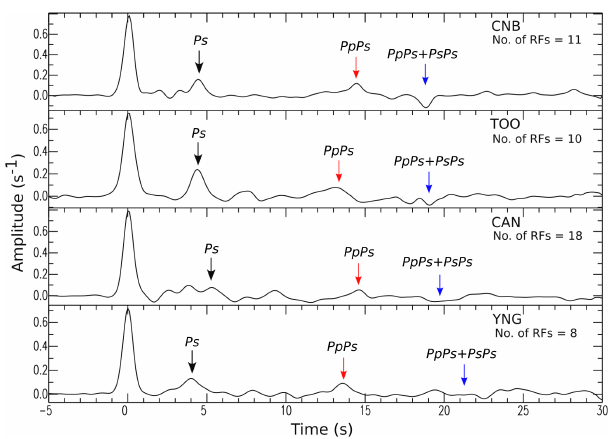
Figure 4. Stacked receiver functions from the Australian National Seismic Network (ANSN) stations TOO, YNG, and MOO as well as the Global Seismographic Network (GSN) station TAU. Small arrows indicate the arrival of the Ps (black), PpPs (red), and PpPs + PsPs (blue) phases from the